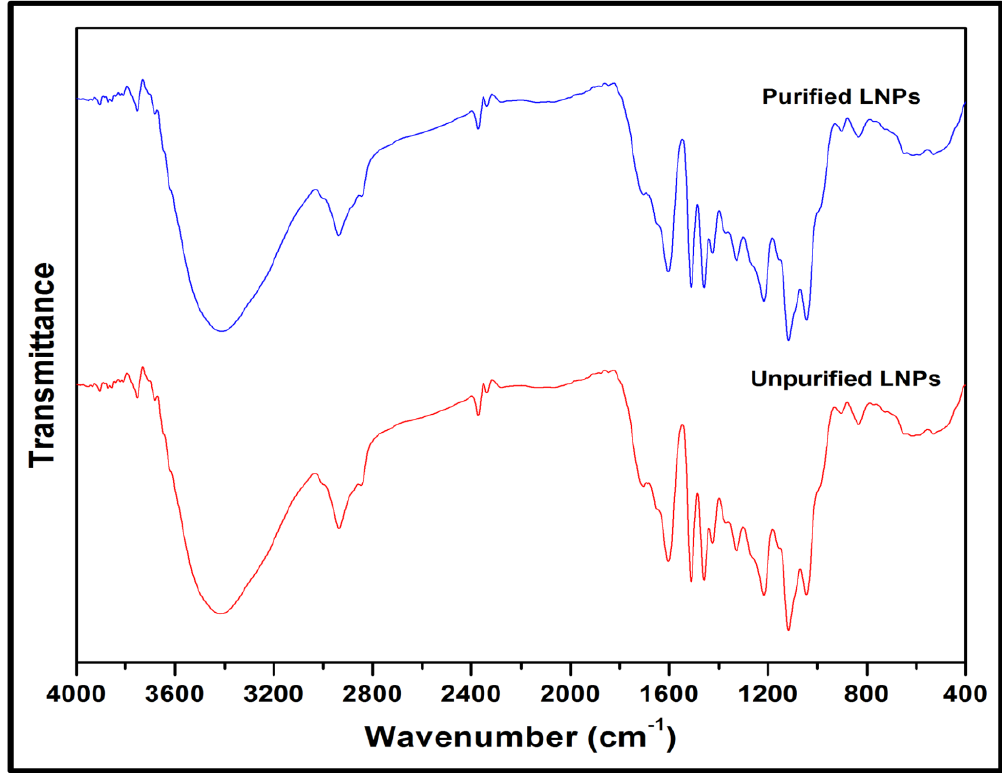
Figure 2. FT-IR spectra of unpurified LNPs and purified LNPs.